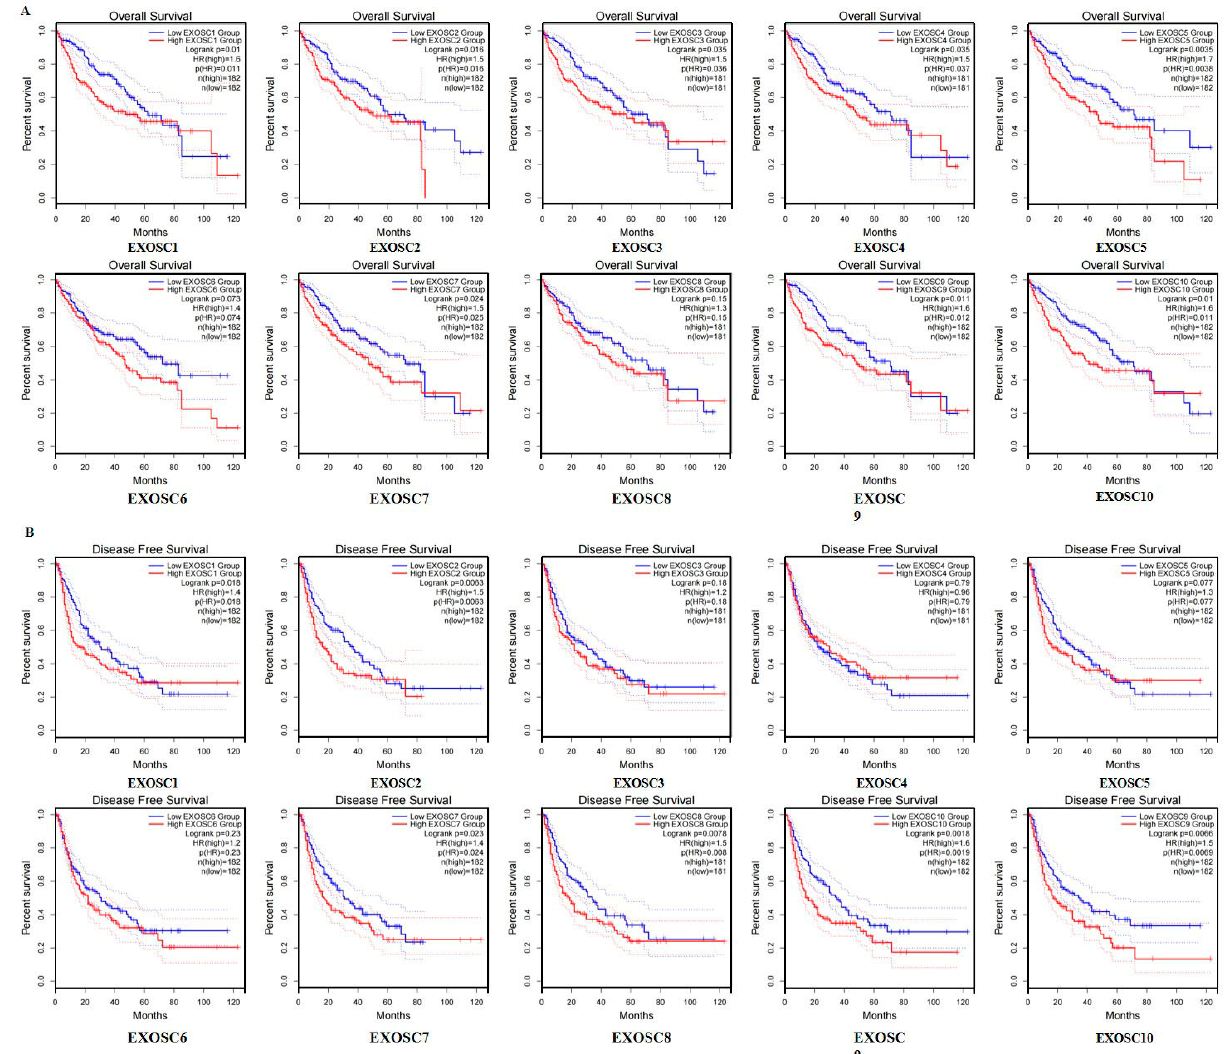
Figure 4. Prognostic potential of the mRNA expression of EXOSCs in HCC (GEPIA). HCC patients with differentially expressed members of EXOSCs were significantly associated with poor ( A ) OS and ( B ) DFS.